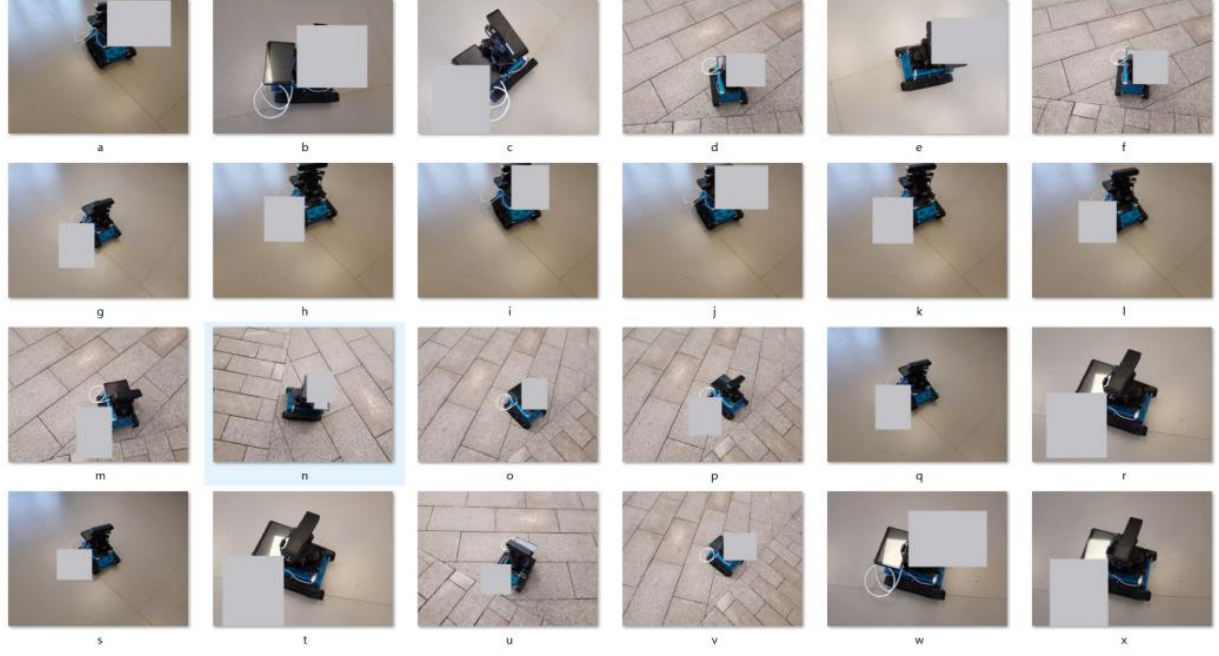
Figure 3. Examples of Screenshots of erased data set in different angles and different environments ( a – x ).